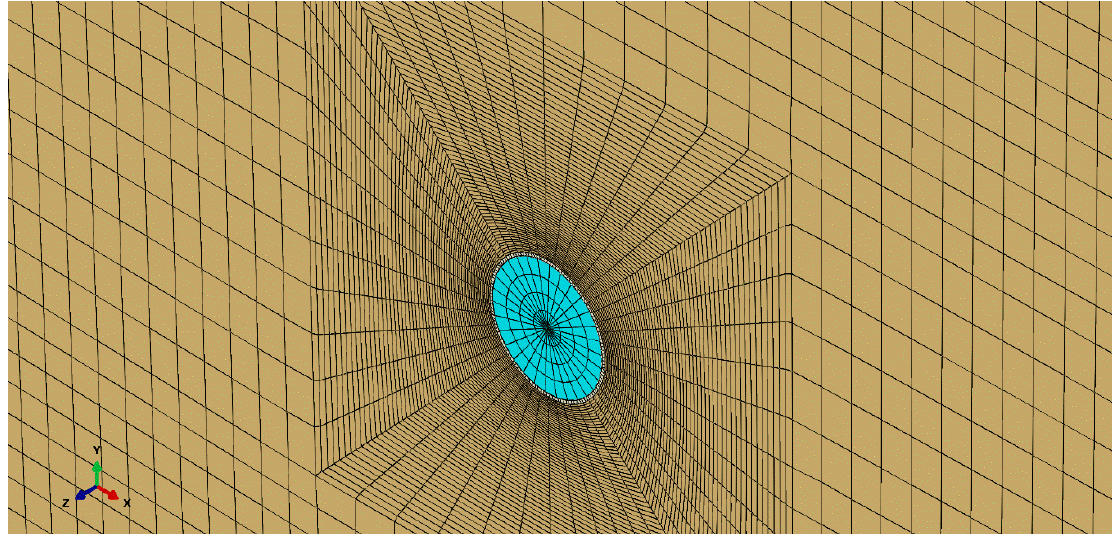
Figure 5. Finite element model mesh—3D View.